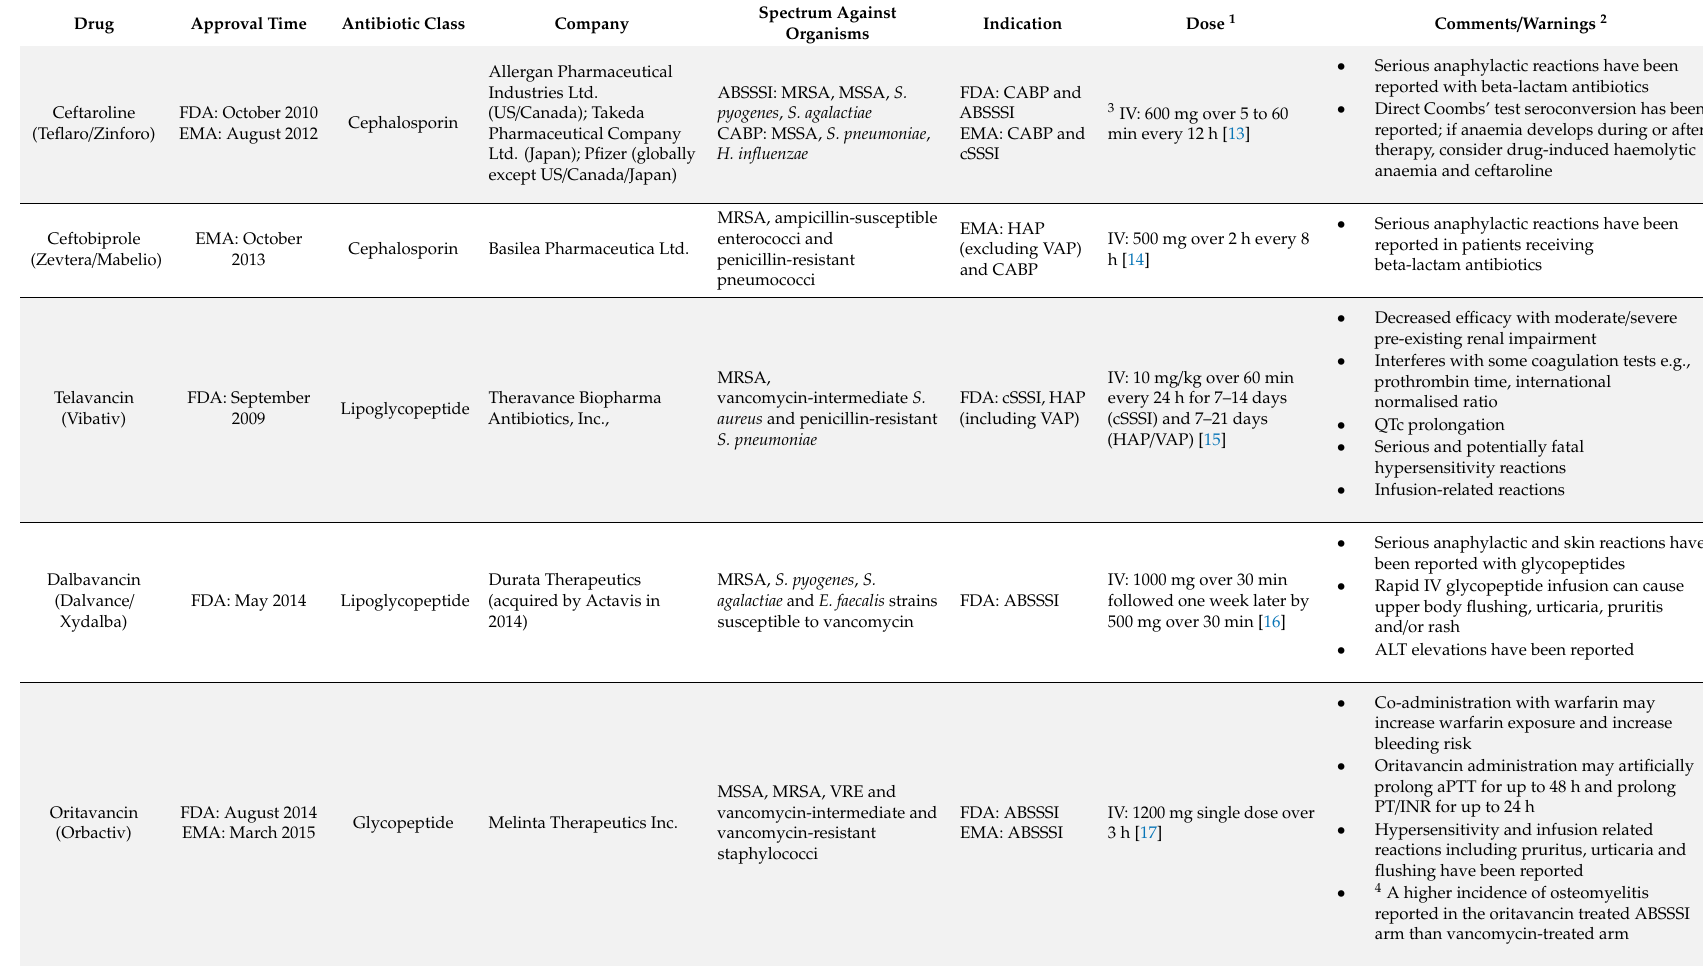
Table 1. Summary of novel antibiotics against Gram-positive bacteria approved by FDA and / or EMA during the last